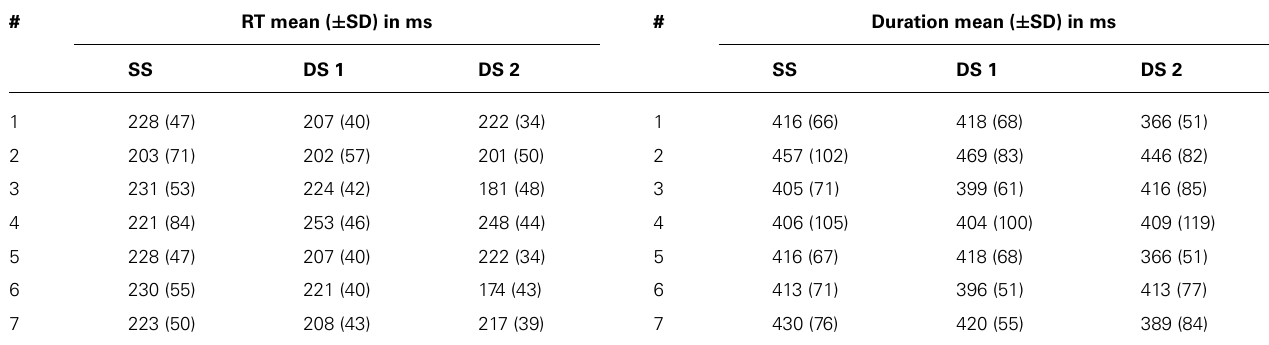
Table 2 |The mean and standard deviation of the reaction times (RT) and movement durations of the single-step (SS), the first double-step (DS 1), and the second double-step (DS 2) movements for all seven datasets.